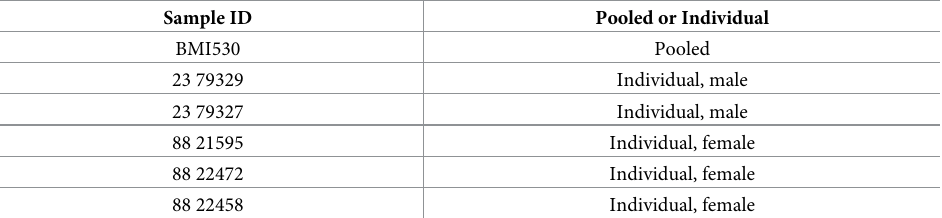
Table 8. Na ï ve human serum samples used to generate